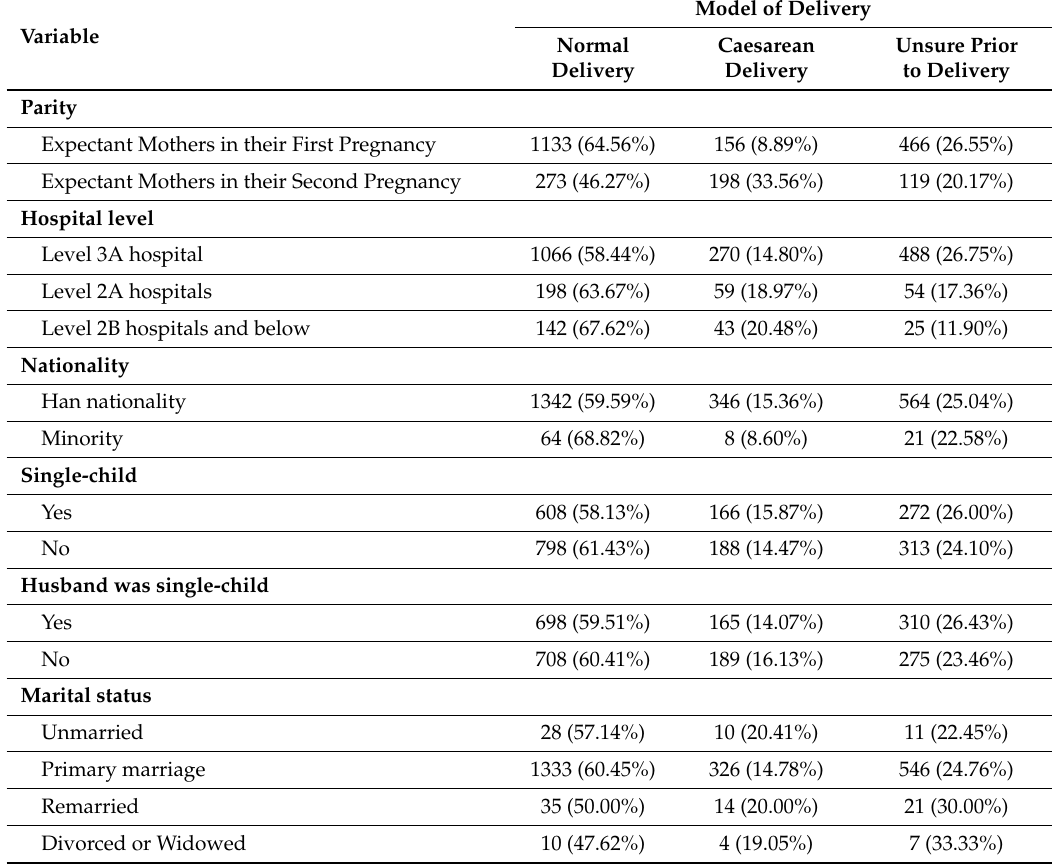
Table 1. The demographic characteristics of expectant mothers stratified by intended delivery